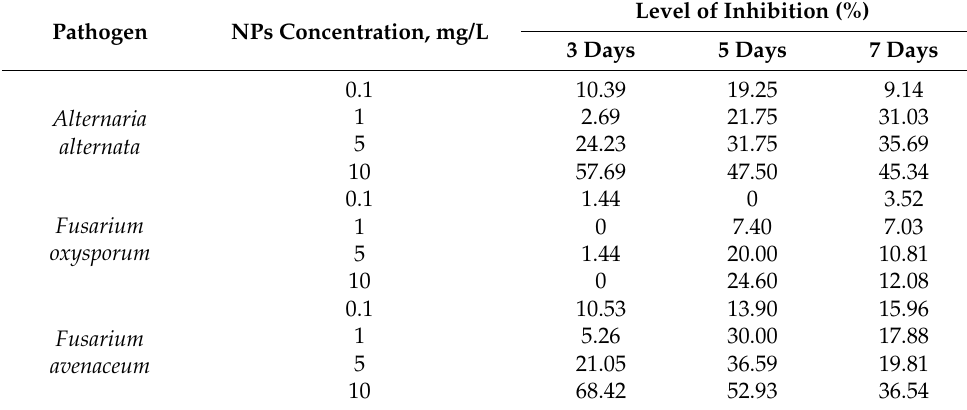
Table 2. The level of fungal growth inhibition under the influence of CuO NPs solutions.